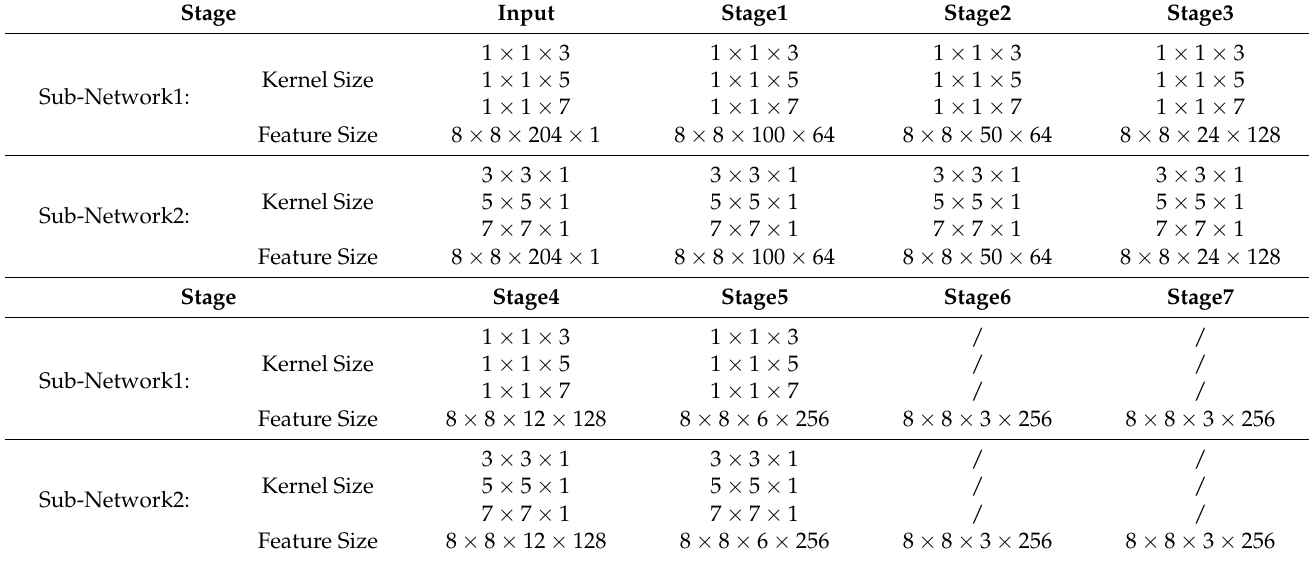
Table 1. Kernel size and feature size information in the networks (taking the SV dataset as an example).